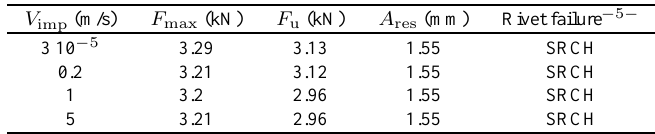
Table 5 Global results of the quasi-static and dynamic shear tests